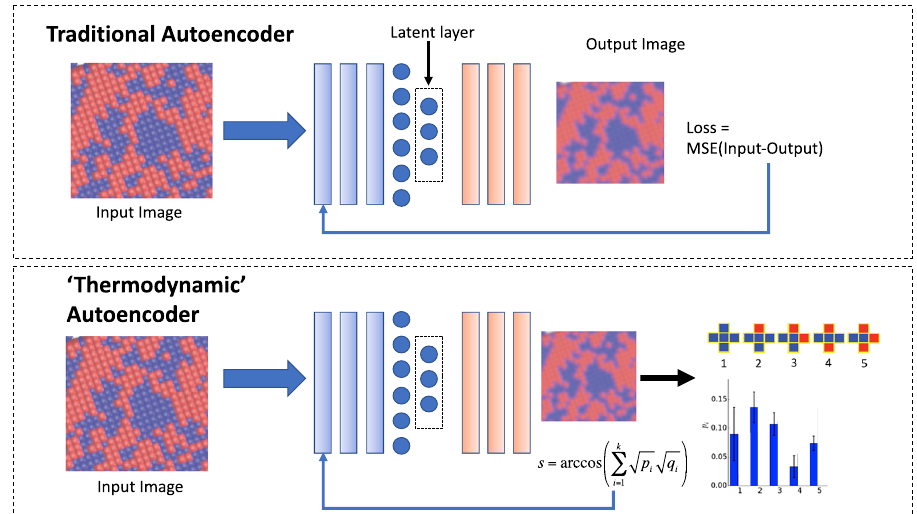
Fig. 4 Adjusting loss functions to emphasize physically meaningful comparisons. A traditional autoencoder contains a loss function that minimizes the mean-squared error between the input and output image or image batches. However, in learning representations for thermodynamic systems, it may be preferable not to output the same image – but rather, to capture the essence of the image, i.e., the statistical fl uctuations of the con fi gurations of species present. In such cases, the loss function can be appropriately modi fi ed, such as with a statistical distance loss function that computes the distance between two systems based on the probability of observing different con fi gurations. Of course, the challenge here is that the con fi gurations to compare should themselves be learned. That may be possible using dual-network architectures, such as generative adversarial networks where one component determines the features that maximize distinguishing of the two systems, while the other network aims to minimize the